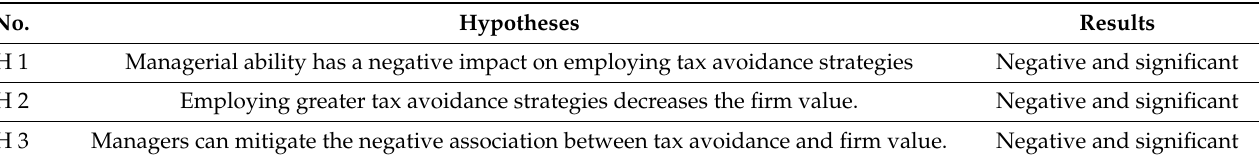
Table 9. The comparison between hypotheses and